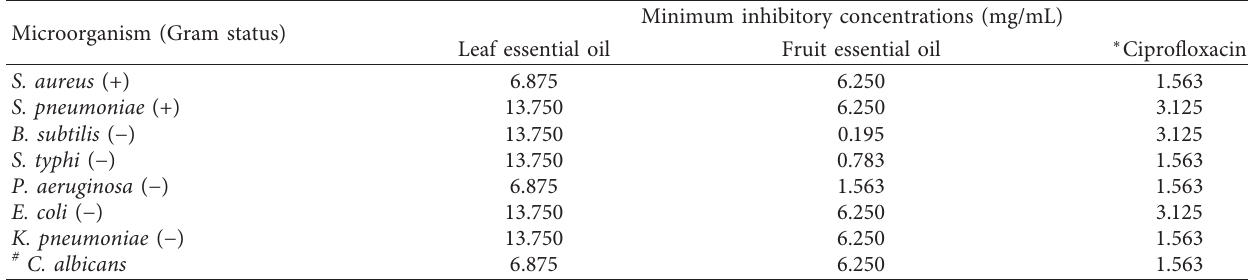
Table 4: Antimicrobial activity: minimum inhibitory concentrations of fruit and leaf essential oils of Chrysophyllum albidum against various pathogenic microorganisms.